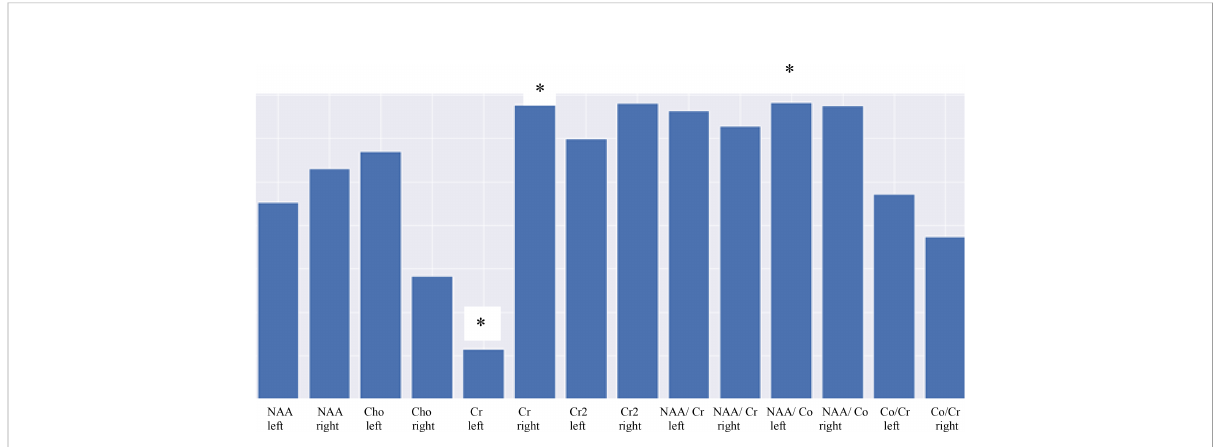
FIGURE 2 Diagram showing the signi fi cance of MRS parameters highlighting the importance of features. * - statistical signi fi cance (p ≤